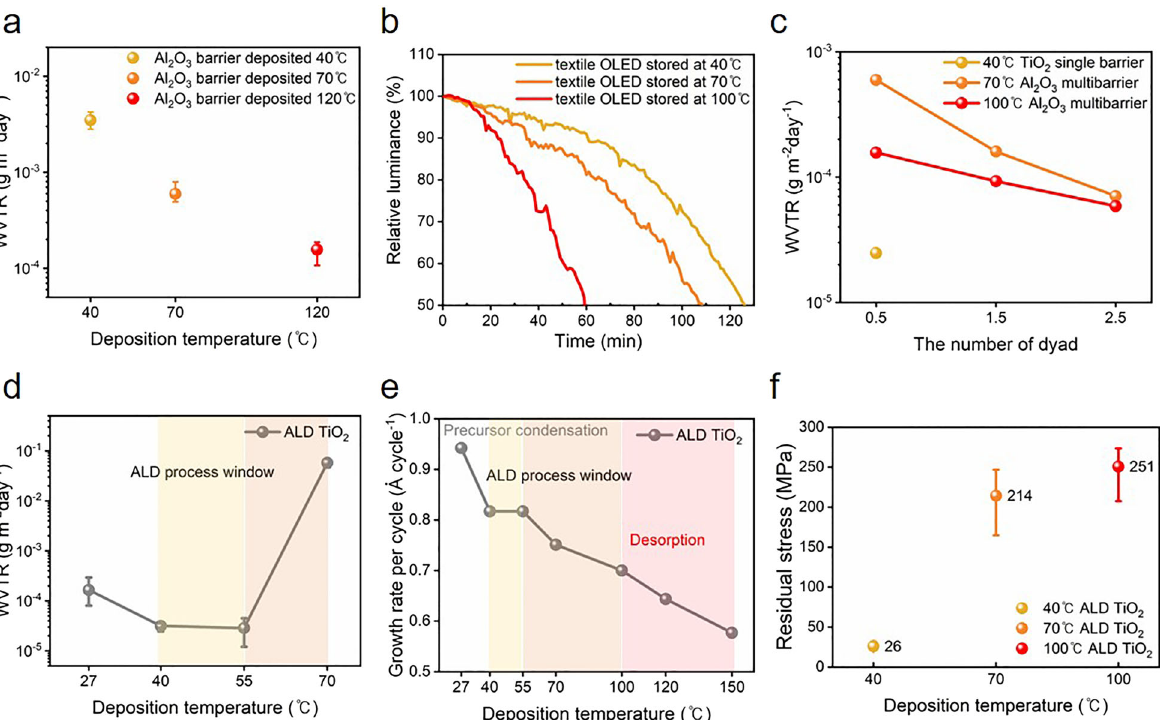
Fig. 2 WVTR of the ALD TiO 2 depending on the deposition temperature. a WVTR of the Al 2 O 3 encapsulation layer depending on the deposition temperature. b Operating lifetime of the textile-based OLEDs depending on the storage temperature. c WVTR of the barriers depending on the deposition temperature and the number of dyads. d WVTR of the TiO 2 thin fi lm depending on the deposition temperature. e ALD process window of TiO 2 thin fi lm. f Residual stress in the TiO 2 thin fi lm depending on the deposition temperature (with error bars that indicate standard